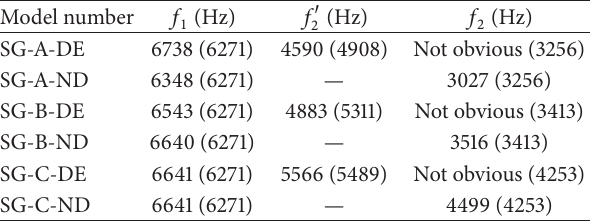
Table 4: Comparison between tested peak frequency and theoreti- cal results under different working conditions.